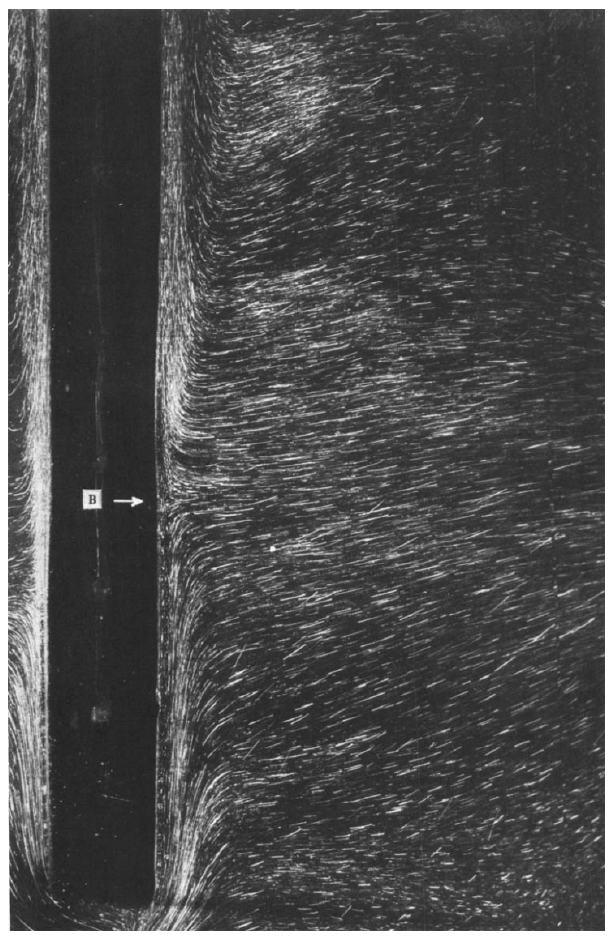
Figure 3. A horizontal jet flows towards the ice, where it then separates into the upward turbulent flow and the downward thermal flow at the bifurcation point, indicated by the letter B in the figure. Reproduced from [103], with permission from Cambridge University Press,